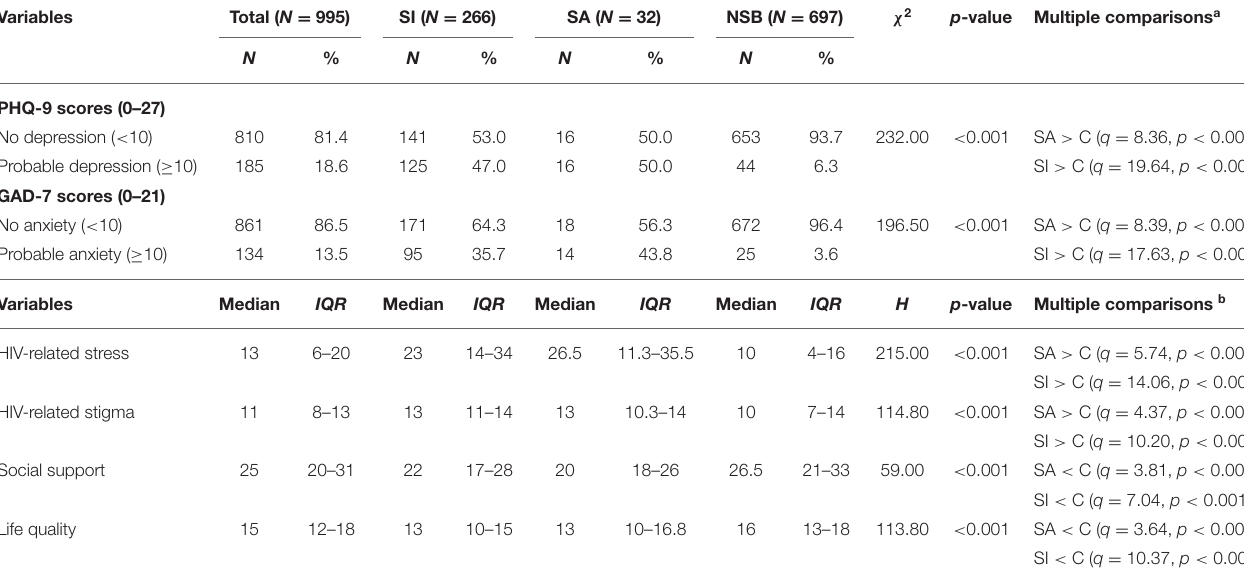
TABLE 3 | Psychosocial characteristics of total samples, SI, SA, and NSB groups of PLWH.